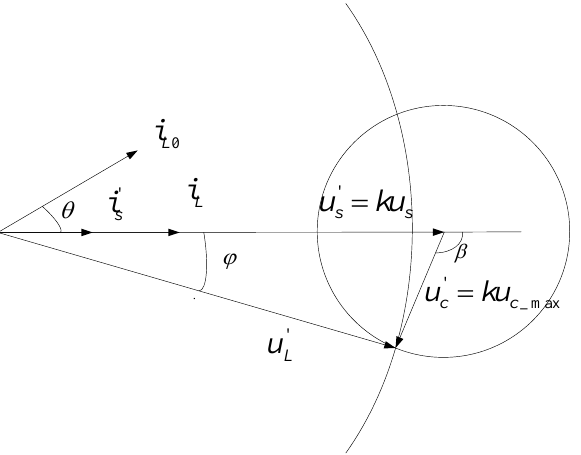
Figure 11. The secondary side voltage vector diagram with maximum reactive power compensation.